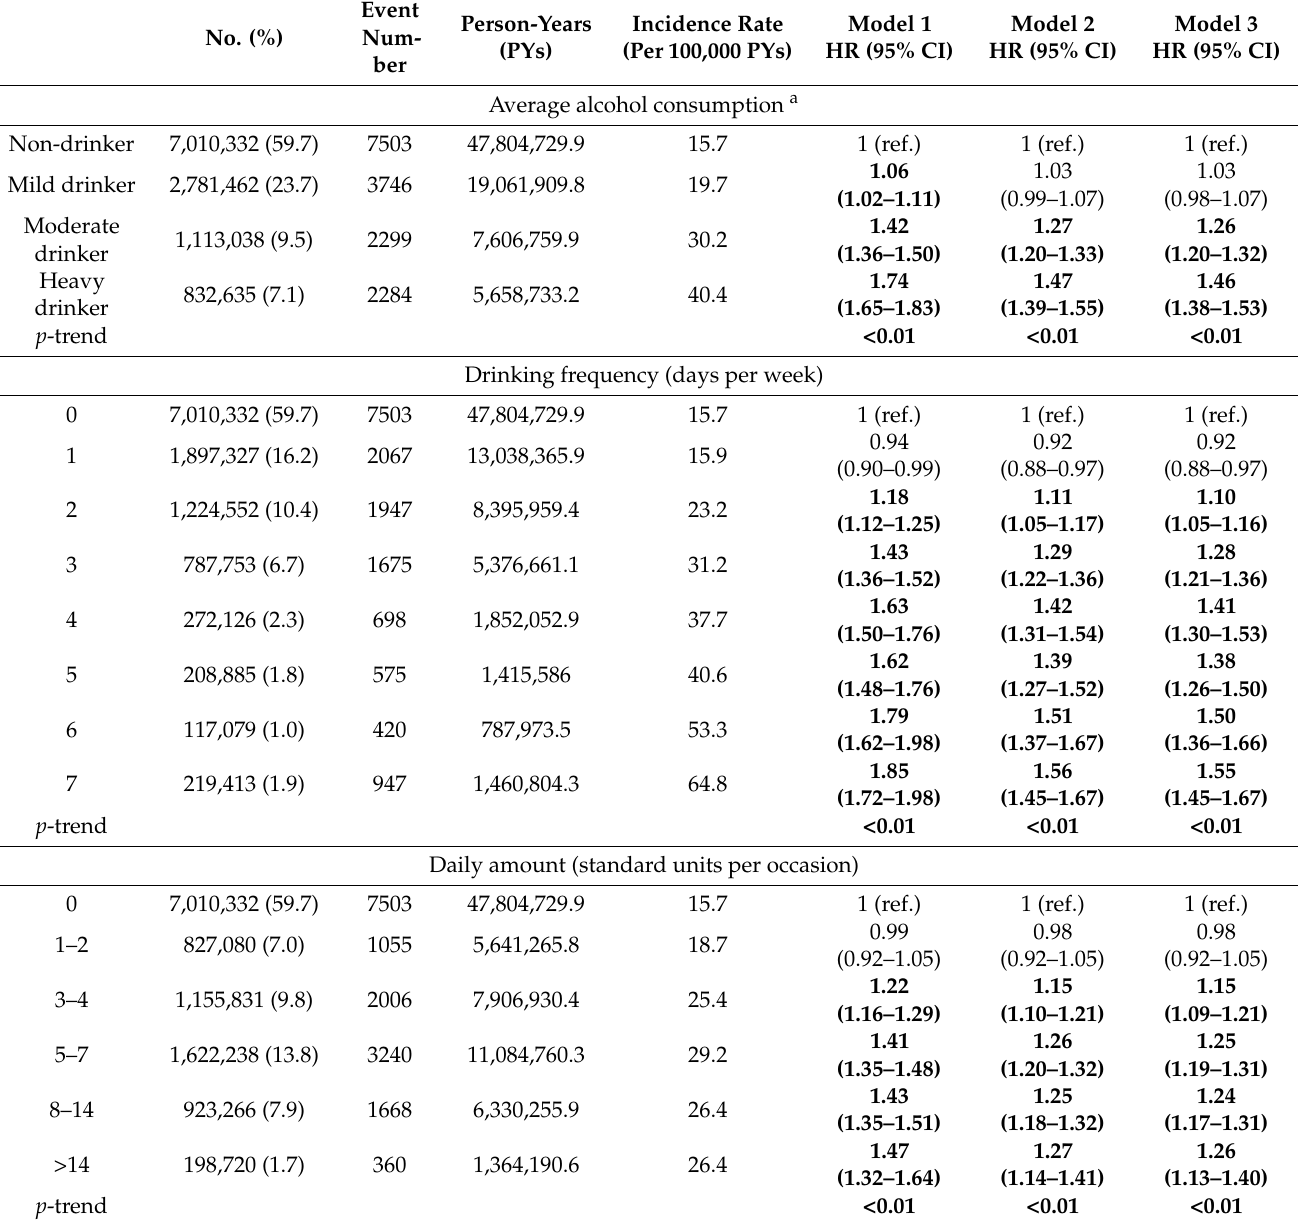
Table 2. Risk of overall head & neck cancer according to drinking